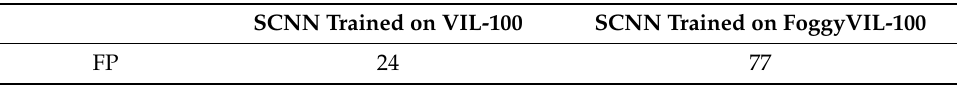
Table 12. Lane detection results of SCNN on real foggy scenes collected from